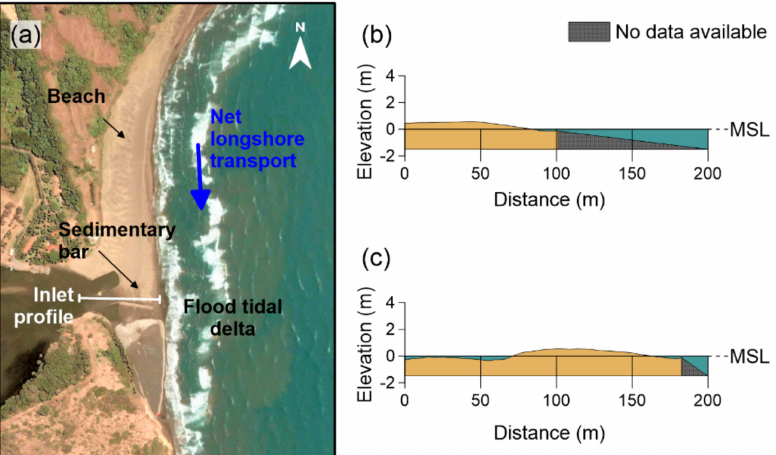
Figure 9. ( a ) Inlet area, and inlet profiles in La Mancha measured during winter storms in November ( b ) 2013 and ( c ) 2014 (data from [12]), see Area B in Figure